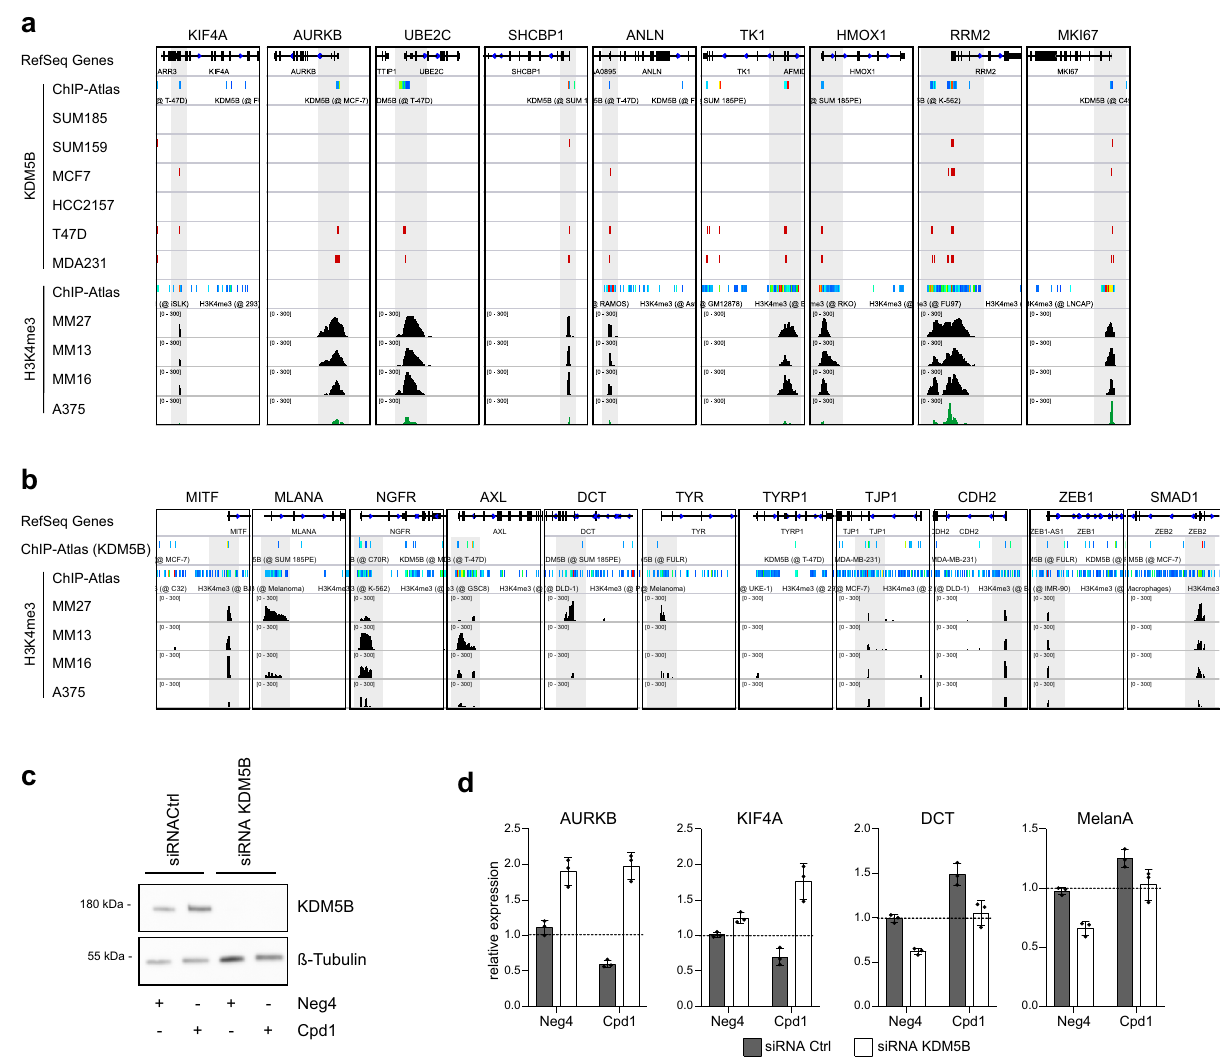
Fig. 5 KDM5B-dependent cytokinesis and differentiation gene transcription. In silico analysis of cytokinesis and mitotic spindle assembly genes ( a ) or differentiation genes ( b ) of KDM5B- and H3K4me3-ChIPseq data from breast cancer cell lines SUM185, SUM159, MCF7, HCC2157, T47D, and MDA231 (GSE46073 42 ) and melanoma cell lines MM27, MM13, MM16 (GSE71854 44 ) and A375 (GSE99835 43 )) and ChIP-Atlas 41 . c KDM5B knockdown in MaMel63a cells was con fi rmed by immunoblotting 4 days after siRNA transfection. d KDM5B target gene expression of cytokinesis-related genes (AURKB, KIF4A) and differentiation-related genes (DCT, MelanA) was analyzed by qPCR 4 days after KDM5B knockdown and 3 days of Neg4 or Cpd1 treatment (10 µ M). Shown is one representative example (mean ± SD, n = 2). Source data are provided as a Source Data fi